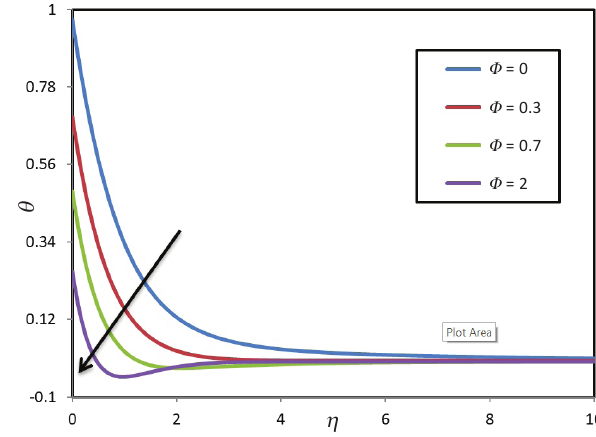
Fig. 5 – θ (temperature) versus h for K= 0.5, I = 0.5, Ec = 0.2, Pr =100 (weak polymers), m = 0.3 (general wedge flow) with F = 0 (no heat sink), –0.3, –0.7,